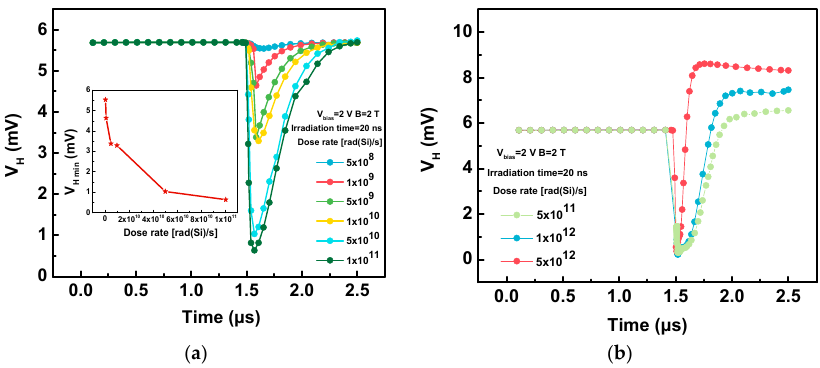
Figure 6. The changes in Hall voltage ( V H ) during the irradiation of ( a ) dose rate = 5 × 10 8 ~1 × 10 11 rad(Si)/s and ( b ) dose rate = 5 × 10 11 ~5 × 10 12 rad(Si)/s. The inset in ( a ) is the change in minimum Hall voltage ( V H min ) with dose rate.